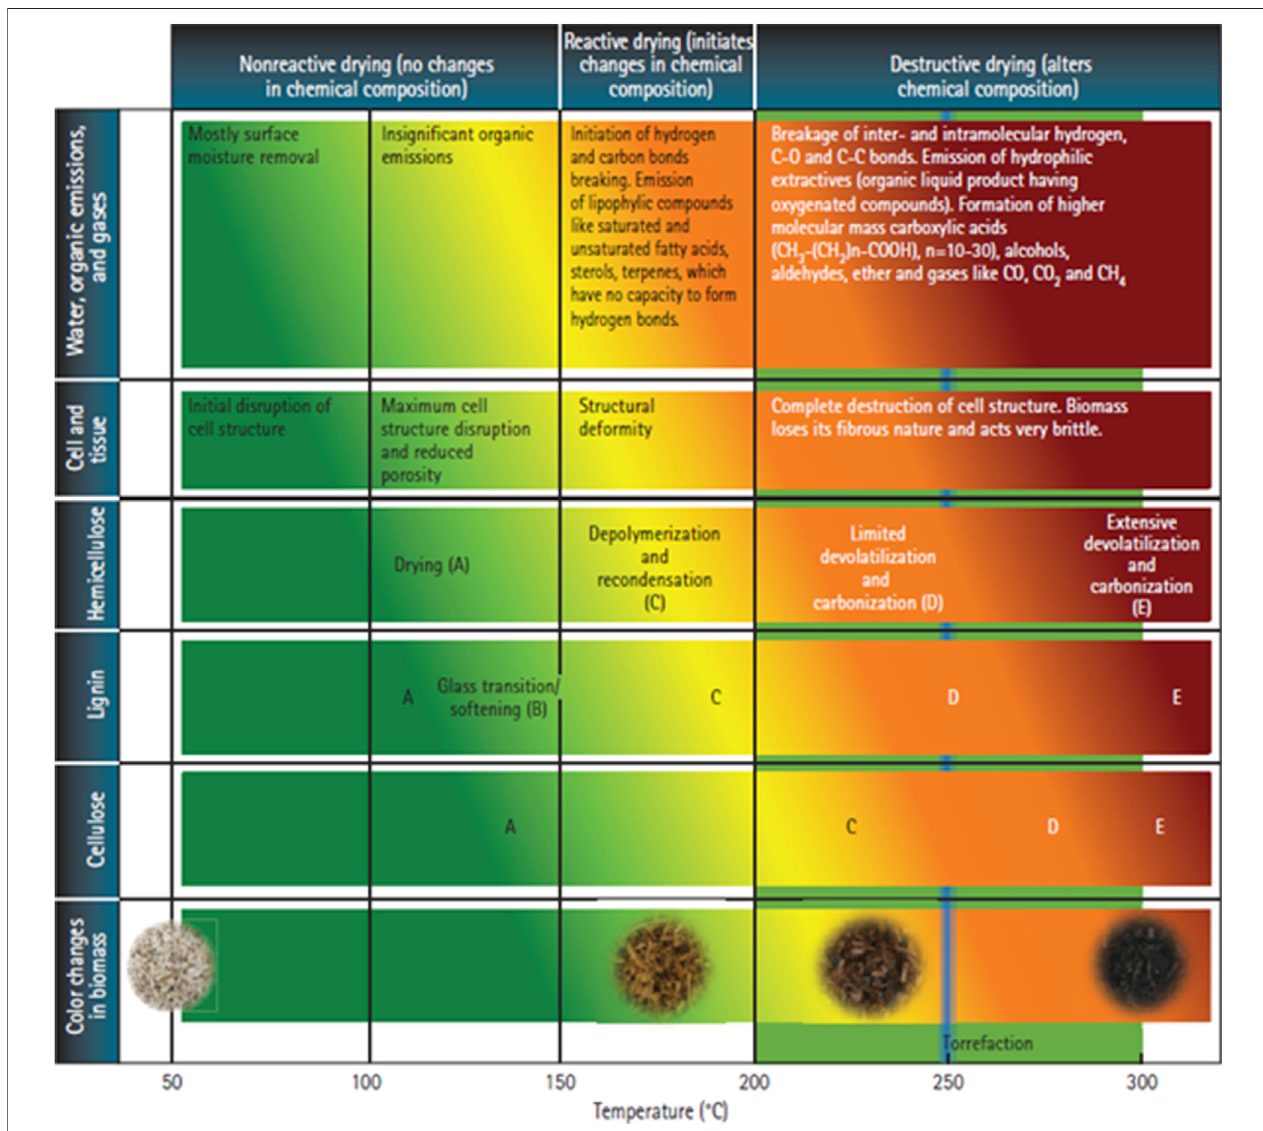
FIGURE 1 | Changes in the biomass at different temperature regimes (Tumuluru et al., 2011).